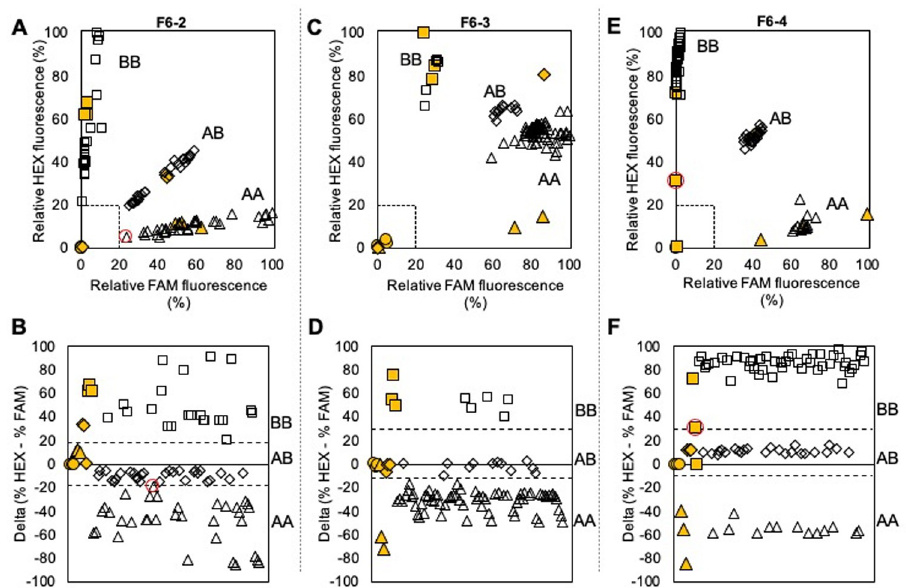
Fig 2. Results from KASP assay for SNPs on Ppe.XapF6 using clean DNA extraction and previously genotyped samples. Solid yellow shapes indicate positive controls, and empty shapes indicate unknowns, with the shape indicating the assigned genotype as follows: circle = no template/no amplification, triangle = AA, diamond = AB, square = BB. Dashed lines in plots in the top row indicate boundaries for no amplification (% fluorescence < ~20% for both fluorophores). Dashed lines in plots in the bottom row indicate delta (% HEX—% FAM) values separating heterozygous and homozygous genotypes, adjusted to reflect assay conditions. Points are automatically encircled in red when they are close enough to the dashed lines in the bottom row that manual inspection is advised. A,B = F6-2; C, D = F6-3; E,F = F6-4.